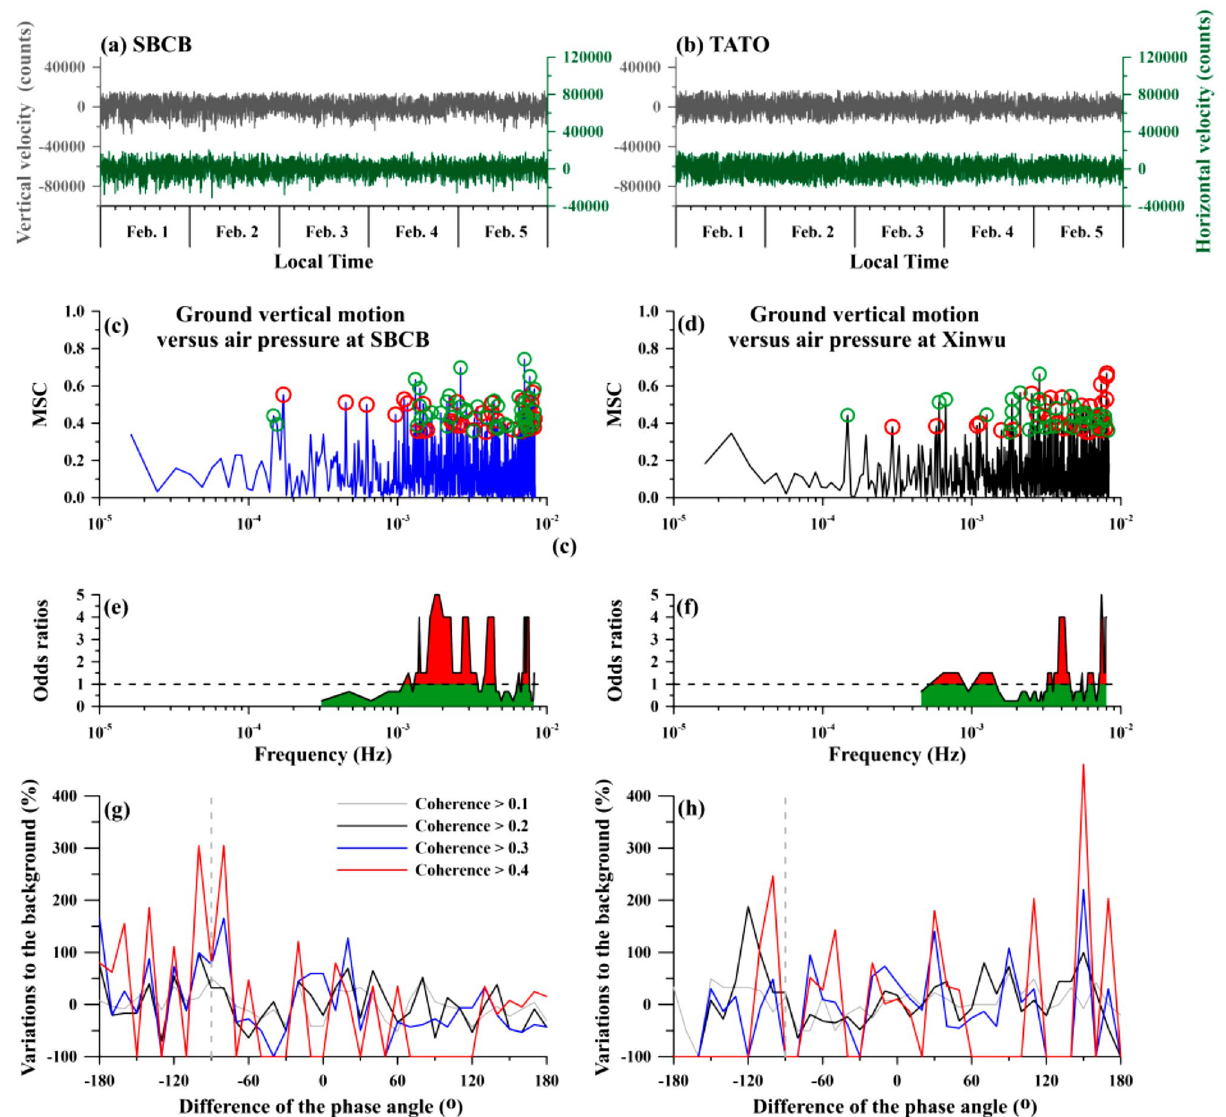
Figure 3. Variations in horizontal and vertical ground velocities and their comparison with air pressure data at the SBCB and around Xinwu stations. The seismic data and analytical results at the SBCB and around Xinwu stations are shown in the left and right panels, respectively. The variations in the horizontal and vertical ground velocities at the SBCB and the TATO stations, which is located close to the Xinwu station, are shown in ( a ) and ( b ). The coherence between the vertical ground velocity and air pressure at the SBCB and around Xinwu stations is shown in ( c ) and ( d ), respectively. Red (green) open circles denote that changes in ground velocity lead (lag) variations in air pressure. ( e ) and ( f ) show the odds ratios with a moving window of 5 events for a coherence > 0.35 in ( c ) and ( d ). The odds test reveals that the leading values are clustered at a few particular frequency bands. ( g ) and ( h ) demonstrate the variations of the phase angle differences for the situation with coherence values larger than the distinct thresholds at the two stations, changes of the air pressure with coherence values > 0. Comparison distributions are constructed by the phase angle differences for the situation with coherence values larger than the thresholds varying from 0.1 to 0.4 with a step of 0.1. The background and comparison distributions are normalized by the total number of them. The normalized background distribution is subtracted from the normalized comparison one and the obtained residual is further divided by the normalized background distribution to understand the variations of the phase angle differences to the background. No obvious characteristics can be found from the variations for the coherence > 0.1 (Fig. 3g). The variations are significant for the phase angle difference ranged between − 80° and − 100° that can be obviously observed for the coherence > 0.3 (Fig. 3g). Analytical results suggest that ground vibrations with P-SV type vibrations can trigger changes of the air pressure. We thus investigated whether air pressure at the Xinwu station changes accordingly or dissipates due to dispersion. We examined the relationship between ground vibrations at the TATO station (24.97°N, 121.50°E)